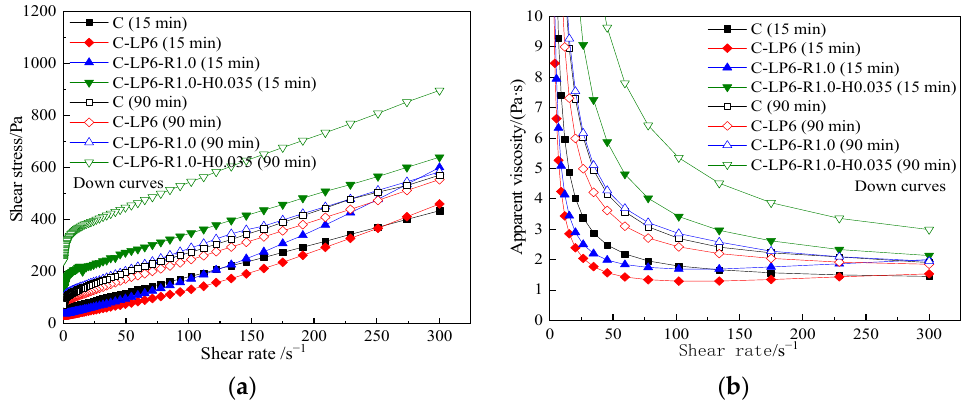
Figure 19. Rheological curves of C-L6-RPP-HPMC pastes. ( a ) shear stress vs. shear rate, ( b ) apparent viscosity vs. shear rate.